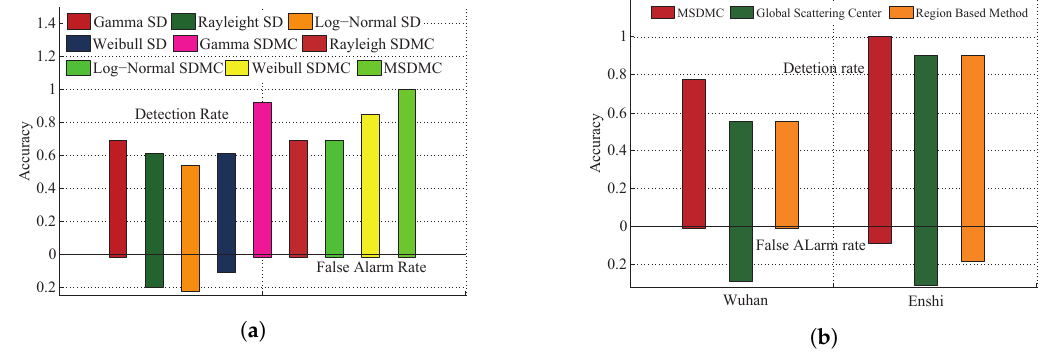
Figure 10. Accuracies for different targets on different spatial resolution SAR imagery. ( a ) airplane as the target; and ( b ) electrical power tower as the